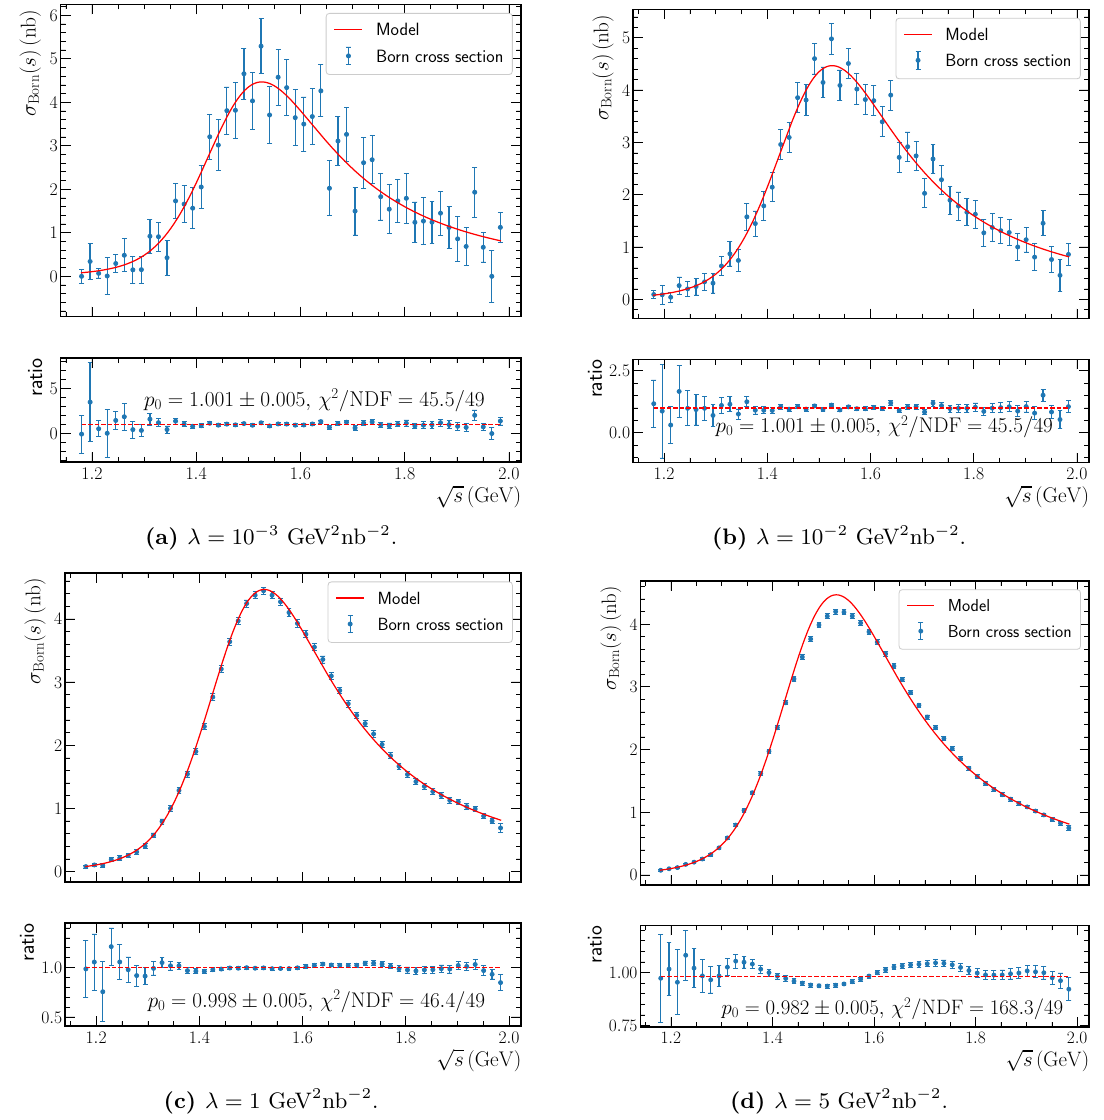
Figure 16. Comparison of the numerical solution of eq. (1.5) and the model Born cross section of the e + e − → ηπ + π − process. The numerical solution is obtained using the Tikhonov regularization method. Each sub-figure corresponds to a separate regularization parameter λ . For each sub-figure, the parameter σ E is 20